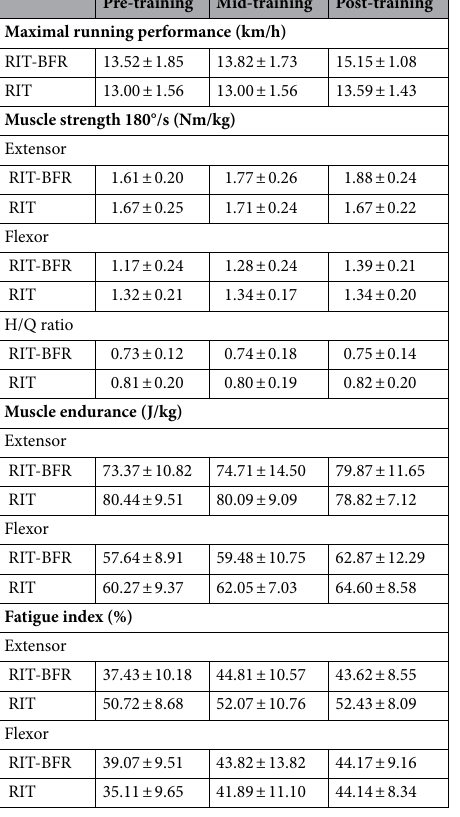
Table 3. Maximal running performance, muscle strength and endurance changes between RIT-BFR and RIT groups. H/Q ratio: hamstring-quadriceps